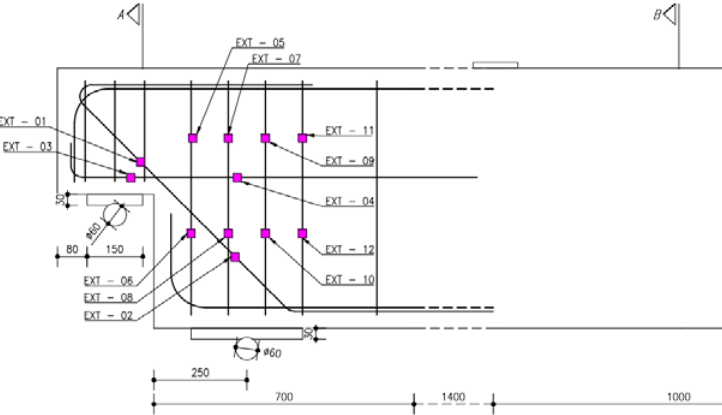
Figure 10. Detail of the strain gauges applied to the reinforcement. the opposite side of the beam.